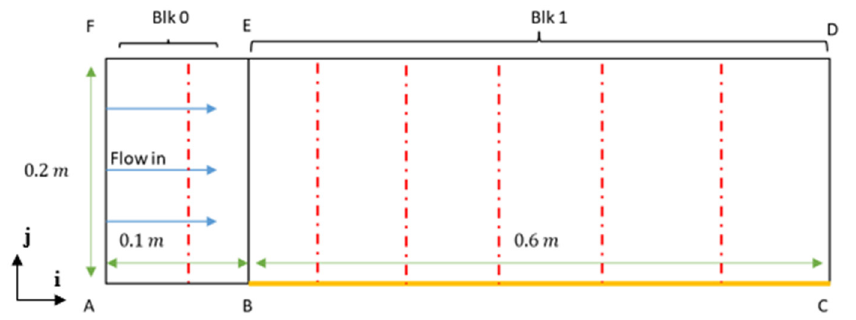
Figure 1. Demonstration of the flat-plate model.